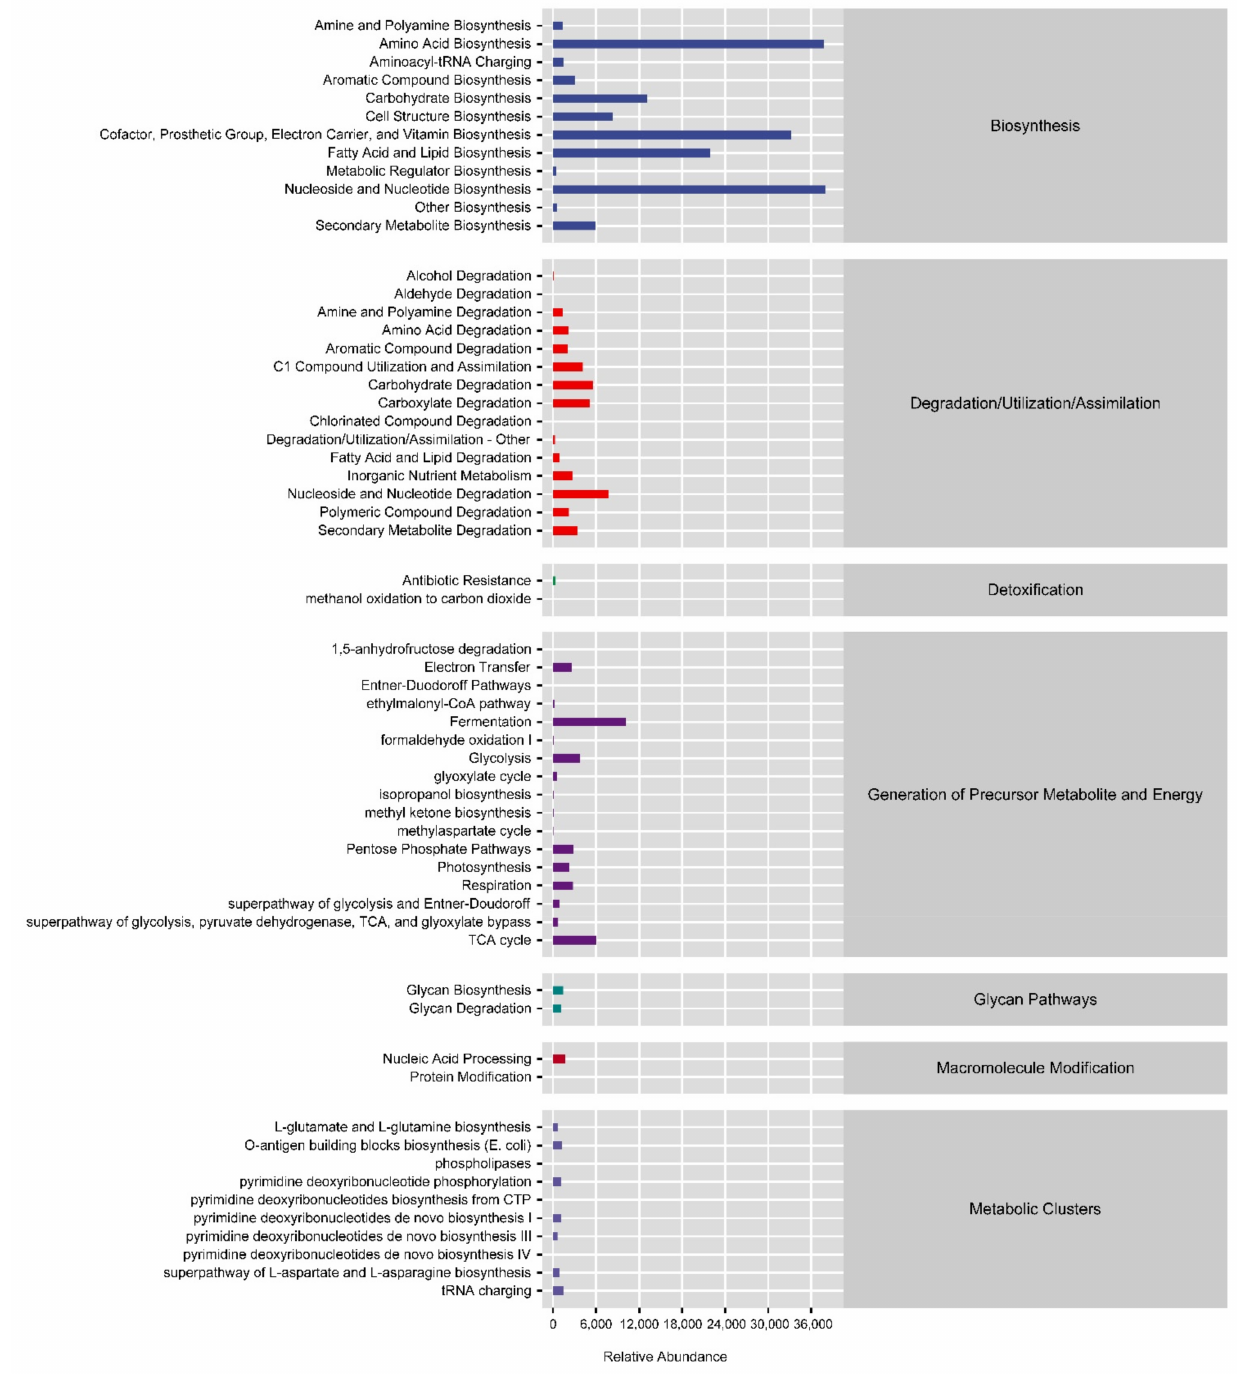
Figure 6. Relative abundances of metabolic pathways in shrimp farm samples different oxygenator conditions. Blue: Biosynthesis; Red: Degradation/Utilization/Assimilation; Light green: Detoxifica- tion; Modena: Generation of precursor metabolite and energy; Olive green: Glycan pathways; Deep red: Macromolecule modification; Orchid: Metabolic